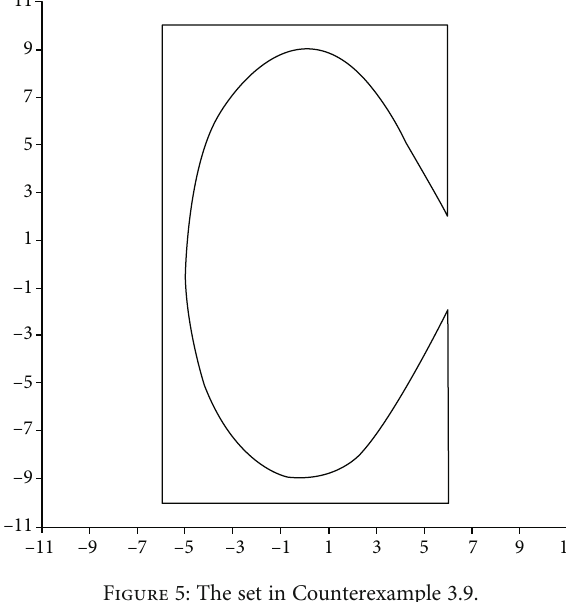
Figure 5: The set in Counterexample